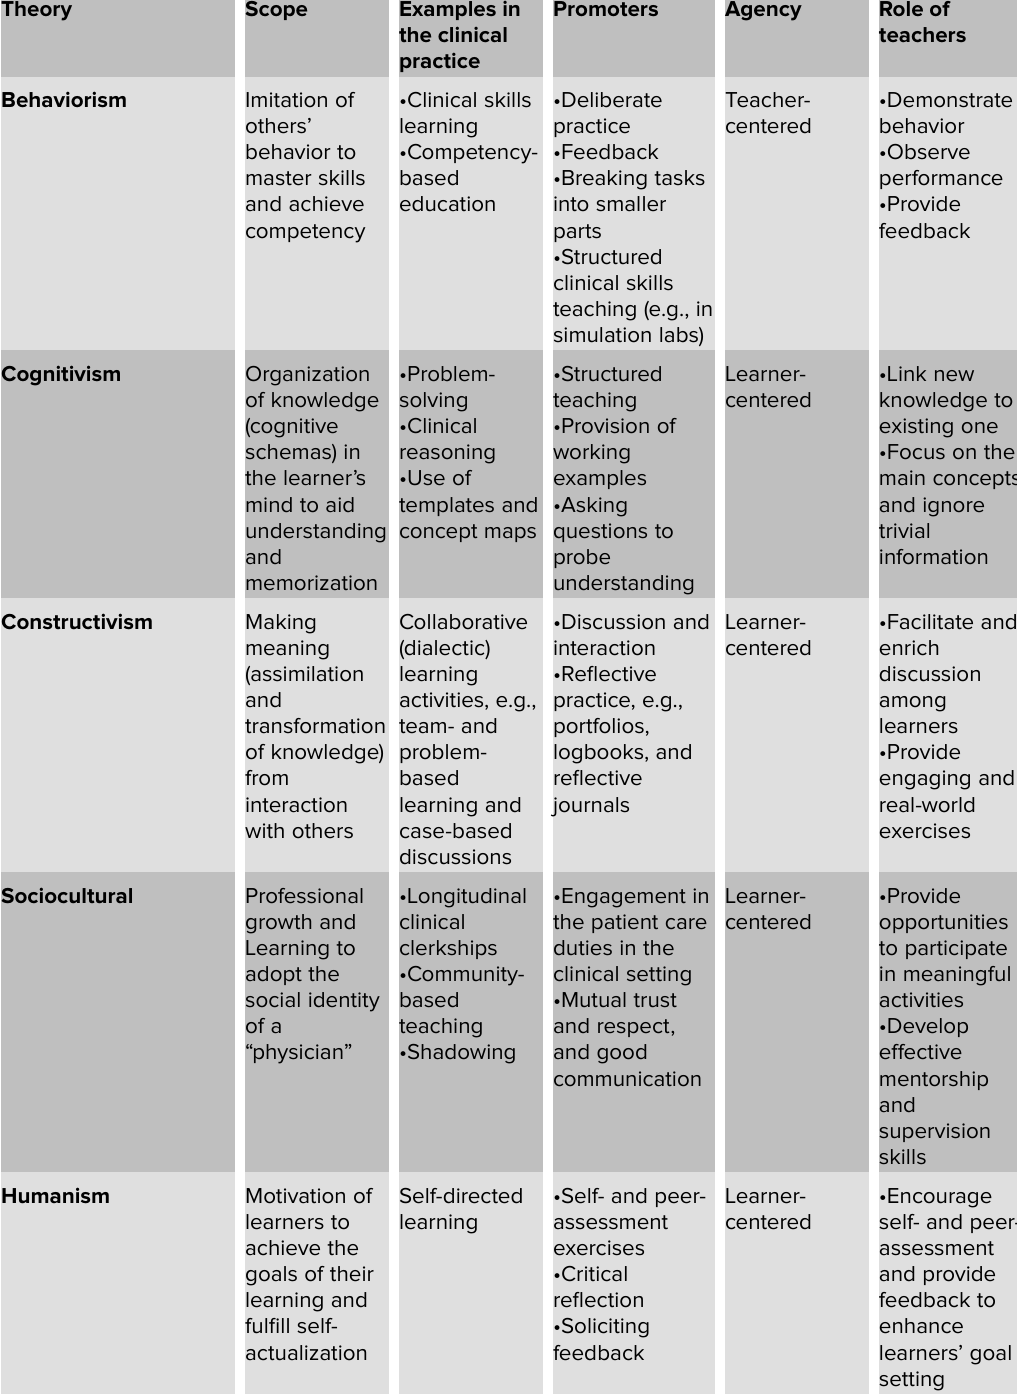
TABLE 1: Summary of the main learning theories and their application in the clinical environment.